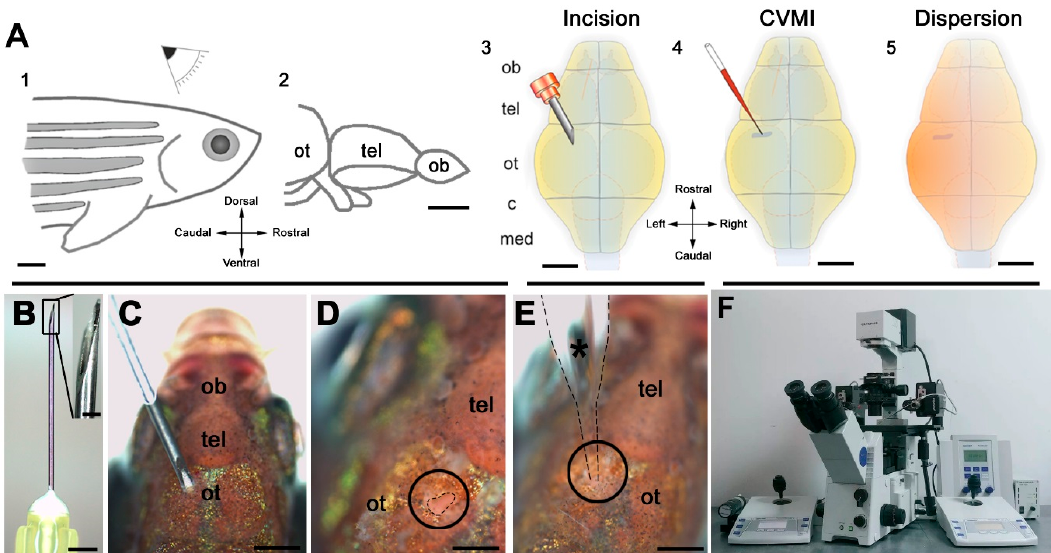
Figure 2. Outline of the pattern and its target regions of cerebroventricular microinjection (CVMI). ( A ) CVMI is achieved at the dorsal surface of the head (1) and targets, in this example, the forebrain that is rostral to the optic tectum (2). For injection, an incision is made into the skull over the optic tectum using a barbed-end canula (3). Through this slit, liquid is injected using a glass capillary (4). Injected liquid disperses rostrally (5). ( B ) The canula used for incision. ( C ) The incision on an adult fish (dorsal view). ( D ) The incision site marked by dashed lines. ( E ) Injection with the glass capillary (*) (dotted lines mark the outline). ( F ) Injection apparatus. Images ( A – E ) are adapted from [132]. (c: cerebellum; med: medulla; ob: olfactory bulb; ot: optic tectum; and tel: telencephalon)